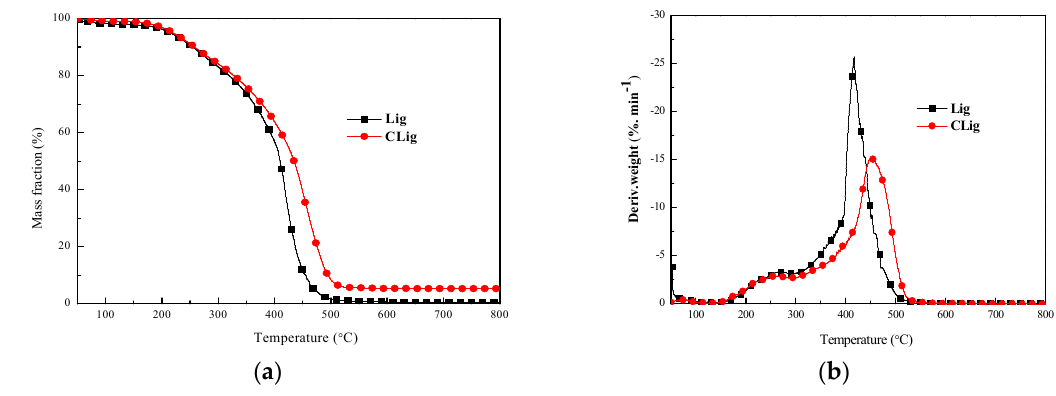
Figure 2. TG curves ( a ) and DTG curves ( b ) of Lig and CLig under air atmosphere. Table 3. Related thermal degradation parameters of Lig and CLig under air atmosphere.